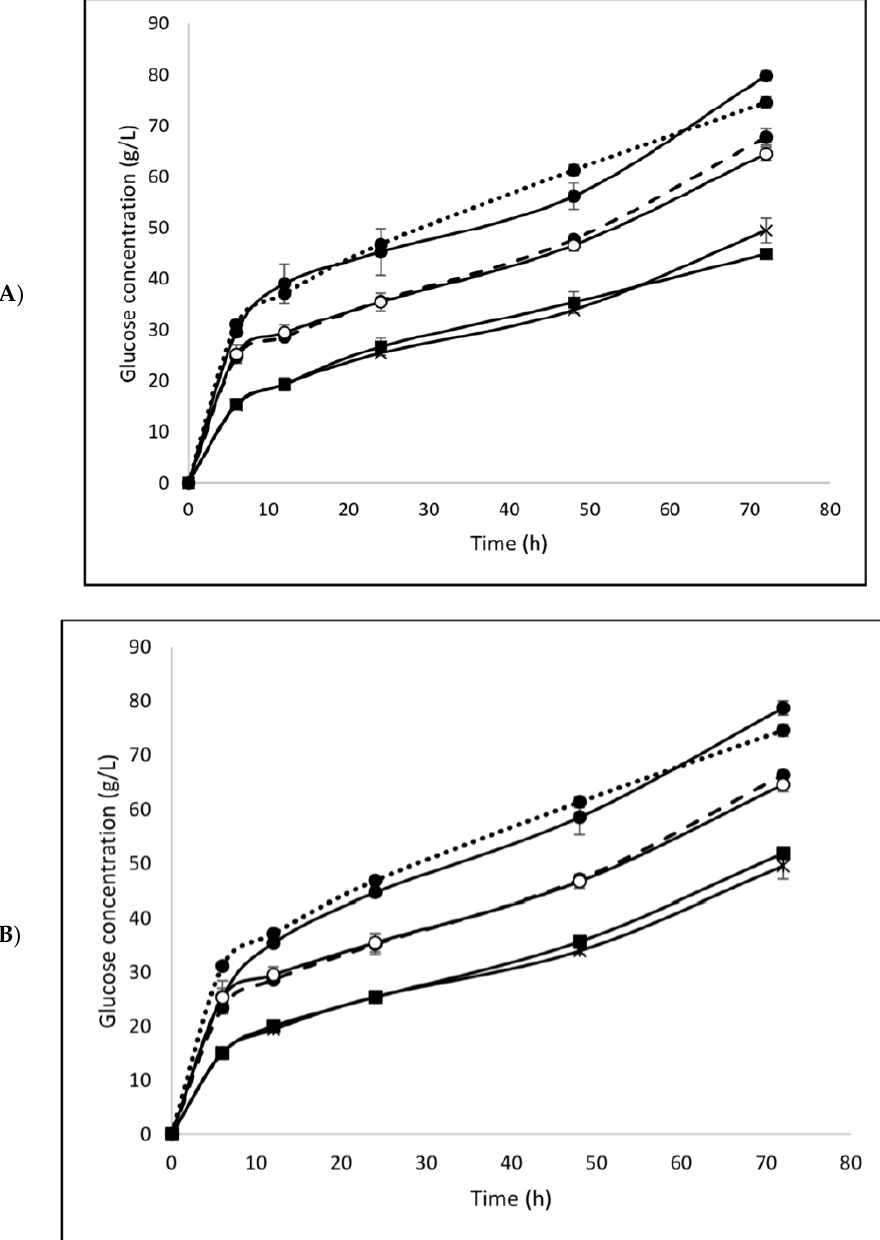
Figure 7. Enzymatic hydrolysis kinetics for enzyme loading evaluation. ( A ) PEG 400; ( B ) Tween 80. ( ■ ) 5 FPU/g glucan; (- -) 10 FPU/g glucan; ( ― ) 15 FPU/g glucan; (X) Control 5 FPU/g glucan; ( ○ ) Table 5. ANOVA for enzyme loading evaluation on surfactant effect. DF SS MS F p -Value